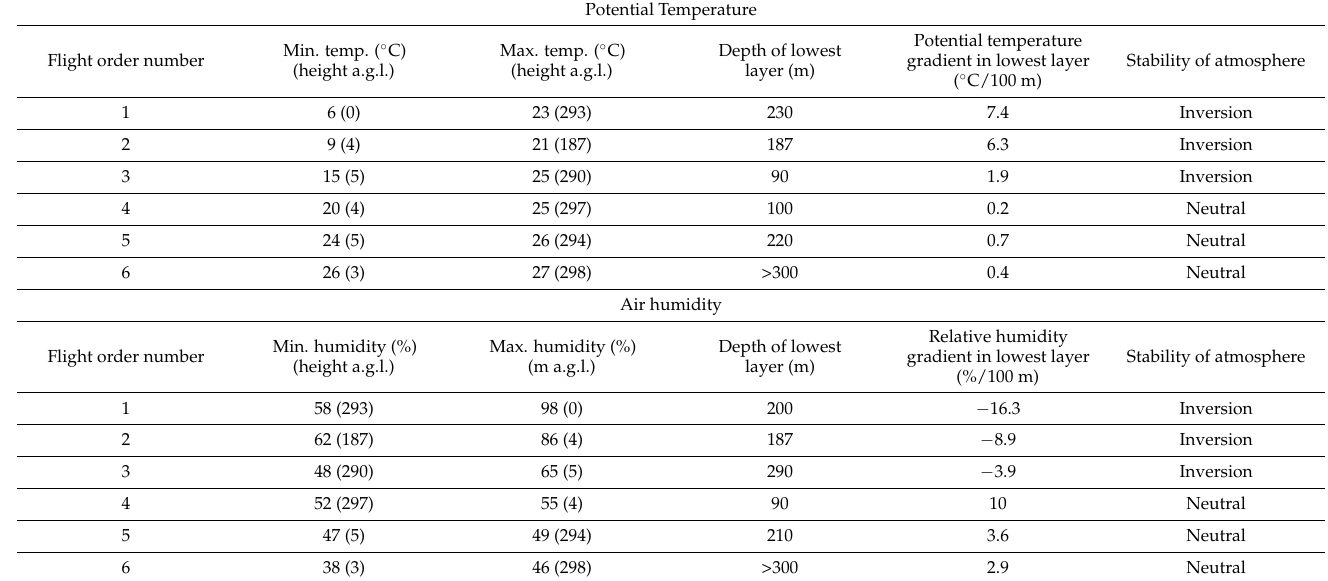
Table A3. Stability of atmosphere on 21 September 2018.